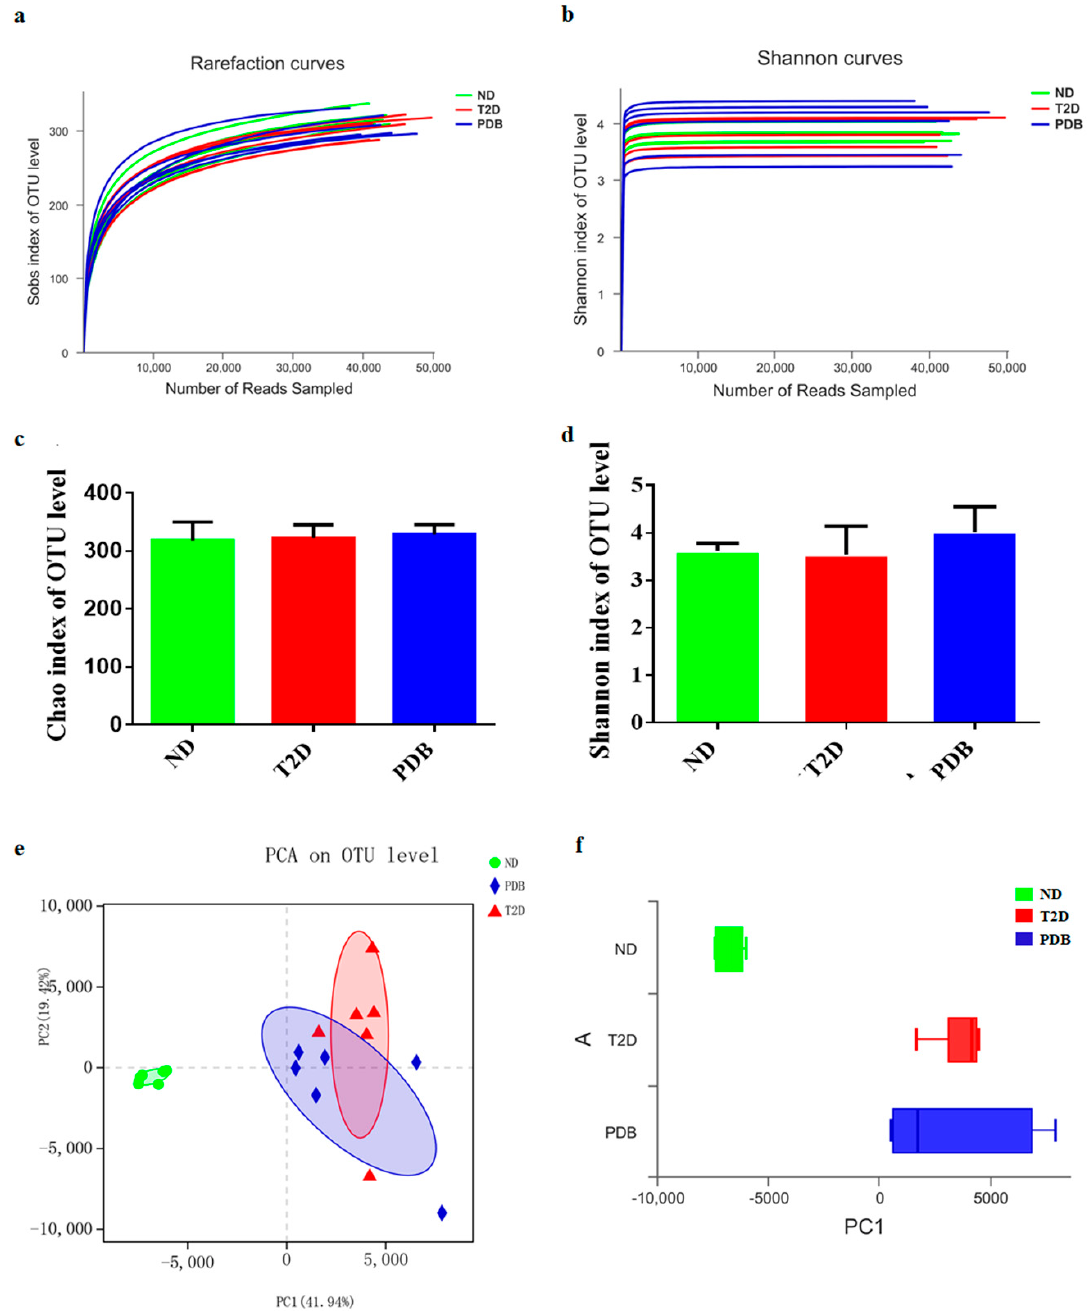
Figure 3. Effects of PDB on the diversity and structure of the gut microbiota in HFD and STZ-treated mice. Rarefaction curves of observed species from fecal samples including sobs index ( a ) and Shannon index ( b ). The α -diversity including Chao index ( c ) and Shannon index ( d ). The β -diversity presenting as principal component analysis PCA ( e and f ). There were six mice in each group.